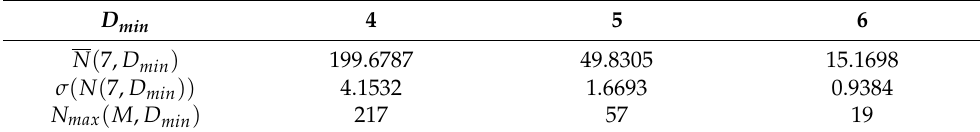
Figure 3 shows a histogram of the distribution of a random value N ( M , D min ) for M = 7 and D min = 4.